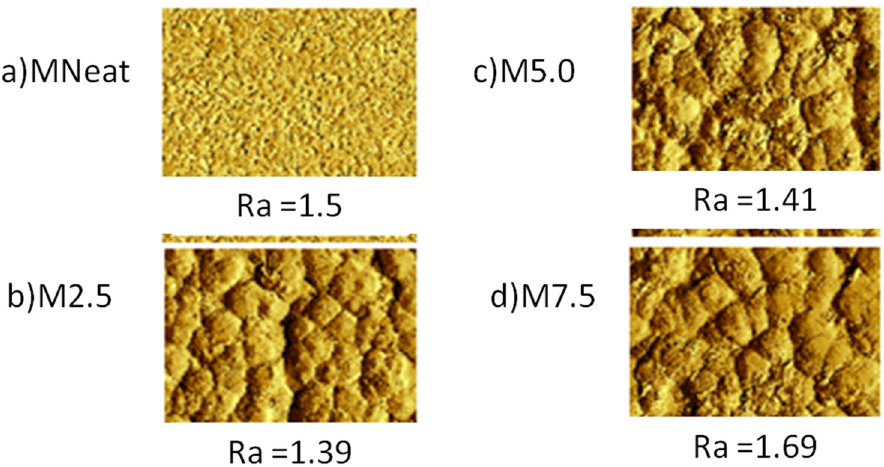
Figure 4. AFM images of ( a ) MNeat ( b ) M2.5 ( c ) M5.0 and ( d ) M7.5 membranes.